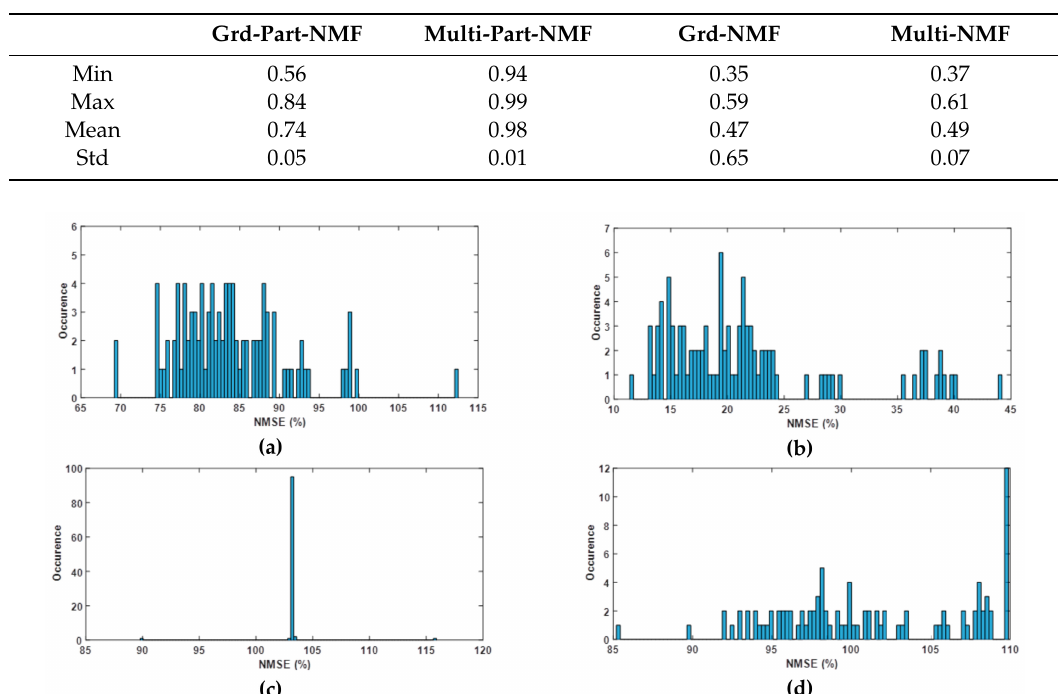
Table 2. Photovoltaic panel | CC | values.